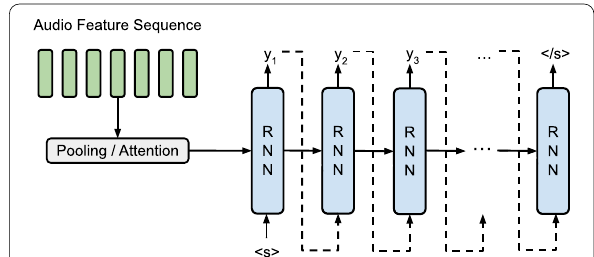
Fig. 5 Diagram of an RNN-based language model. The RNN decoder generates the sentence from the left (i.e., the first word) to the right (i.e., the final word) in an auto-regressive manner, given the audio feature sequence generated from the encoder and previously generated words by the decoder. A start token “
” is fed into the RNN at the first time step to start the generation, while the generation process is terminated when a stop token “
” is